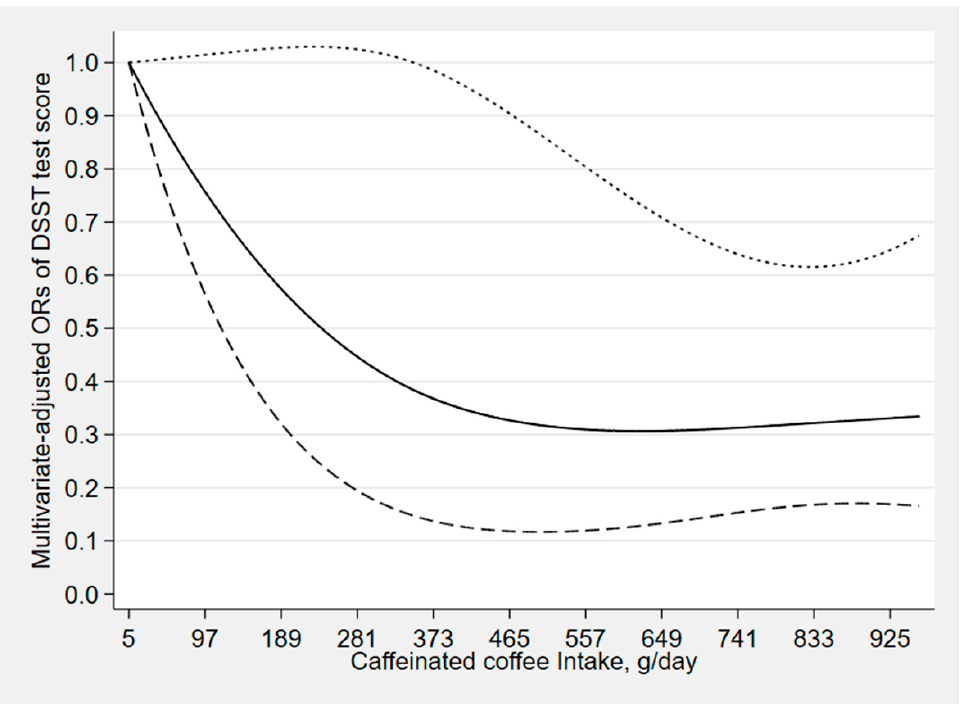
Figure 3. Dose–response relationship between ca ff einated co ff ee and DSST score. The solid line and dashed line represent the estimated ORs and their 95% confidence intervals (OR, odds ratio).